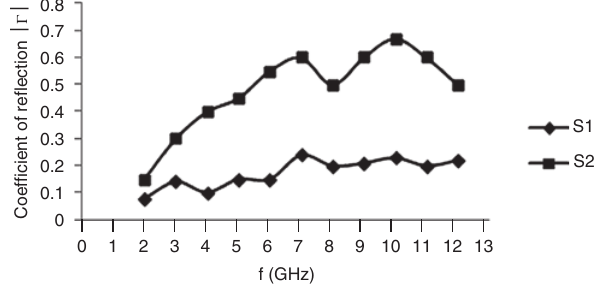
Figure 12: Frequency dependence of reflection coefficients | Γ | of a composite containing a carbon black-magnetite hybrid filler (S 1) and a composite containing a physical mixture (S 2).